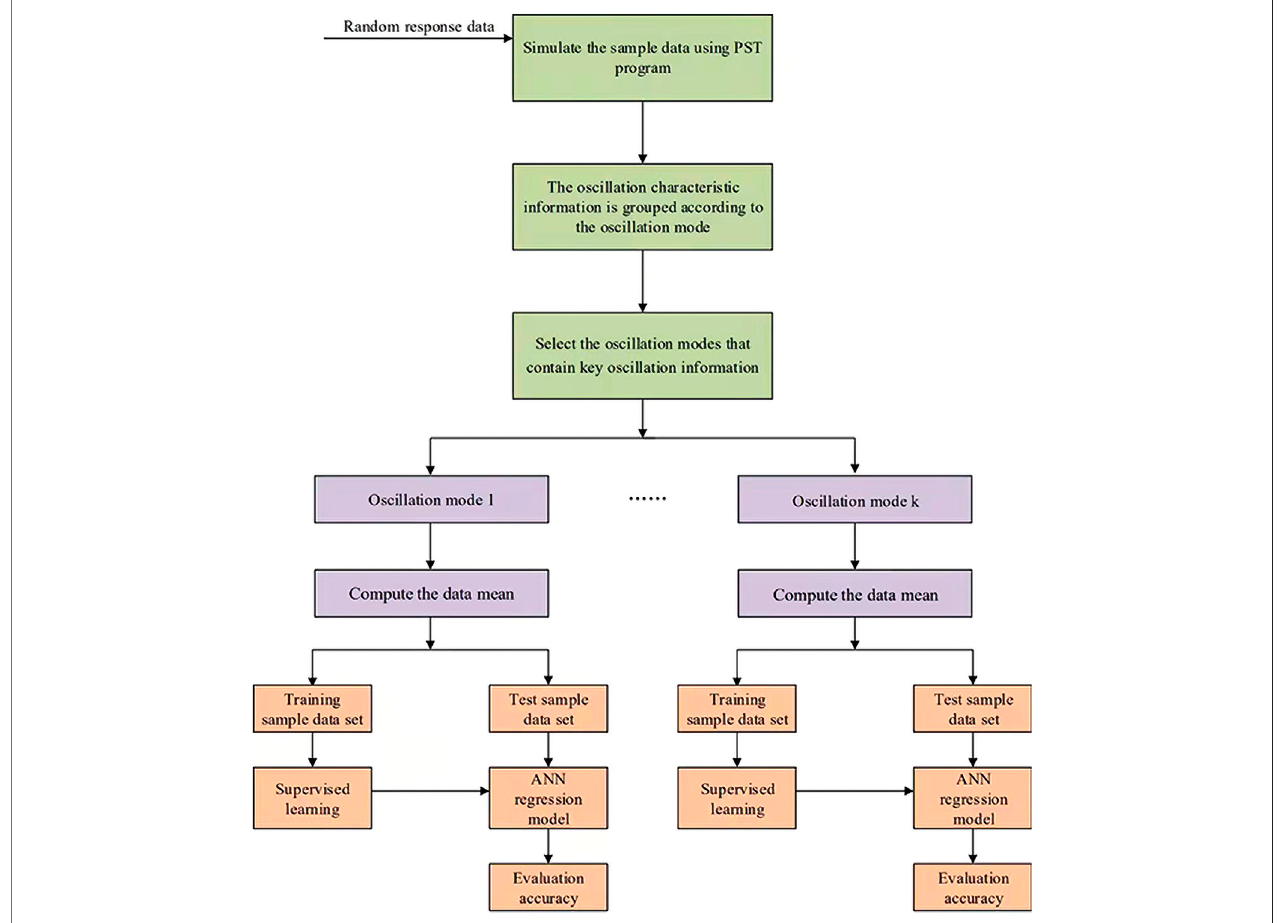
FIGURE 2 | Electromechanical oscillation mode parameter identi fi cation model based on the R-M-ANN.